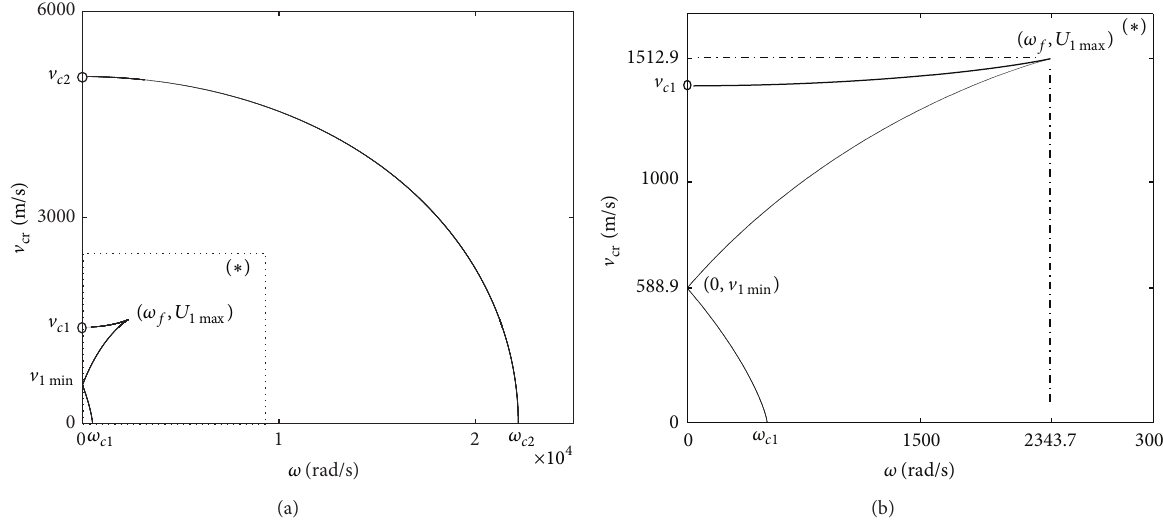
Figure 2: Critical velocity V